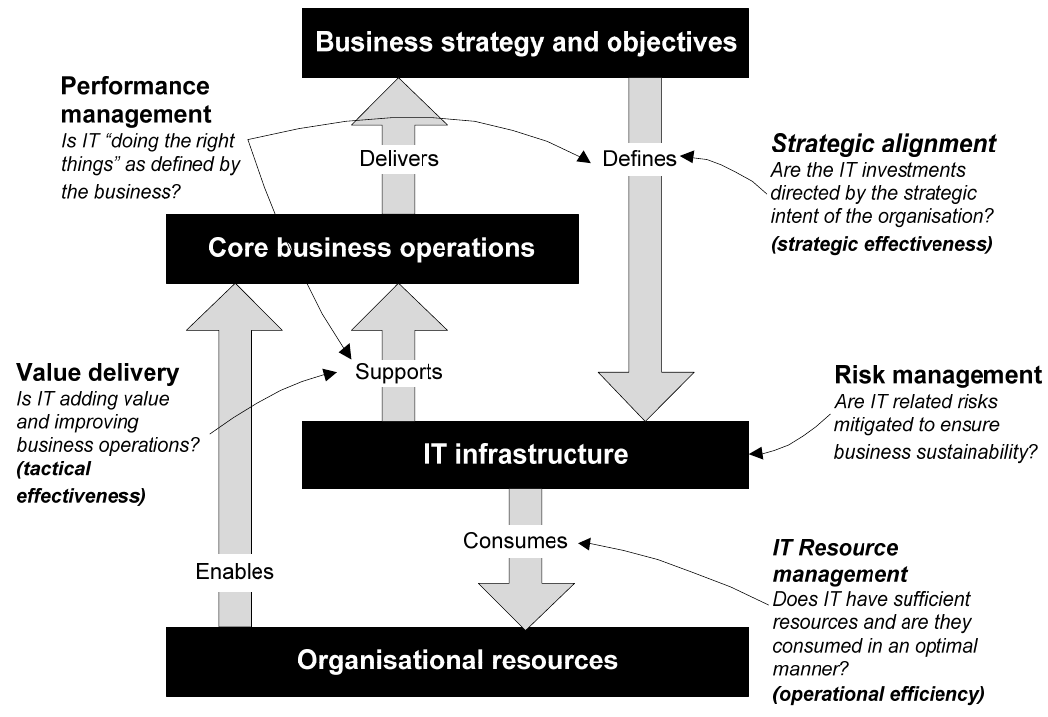
Figure 3: ITG focus areas and business